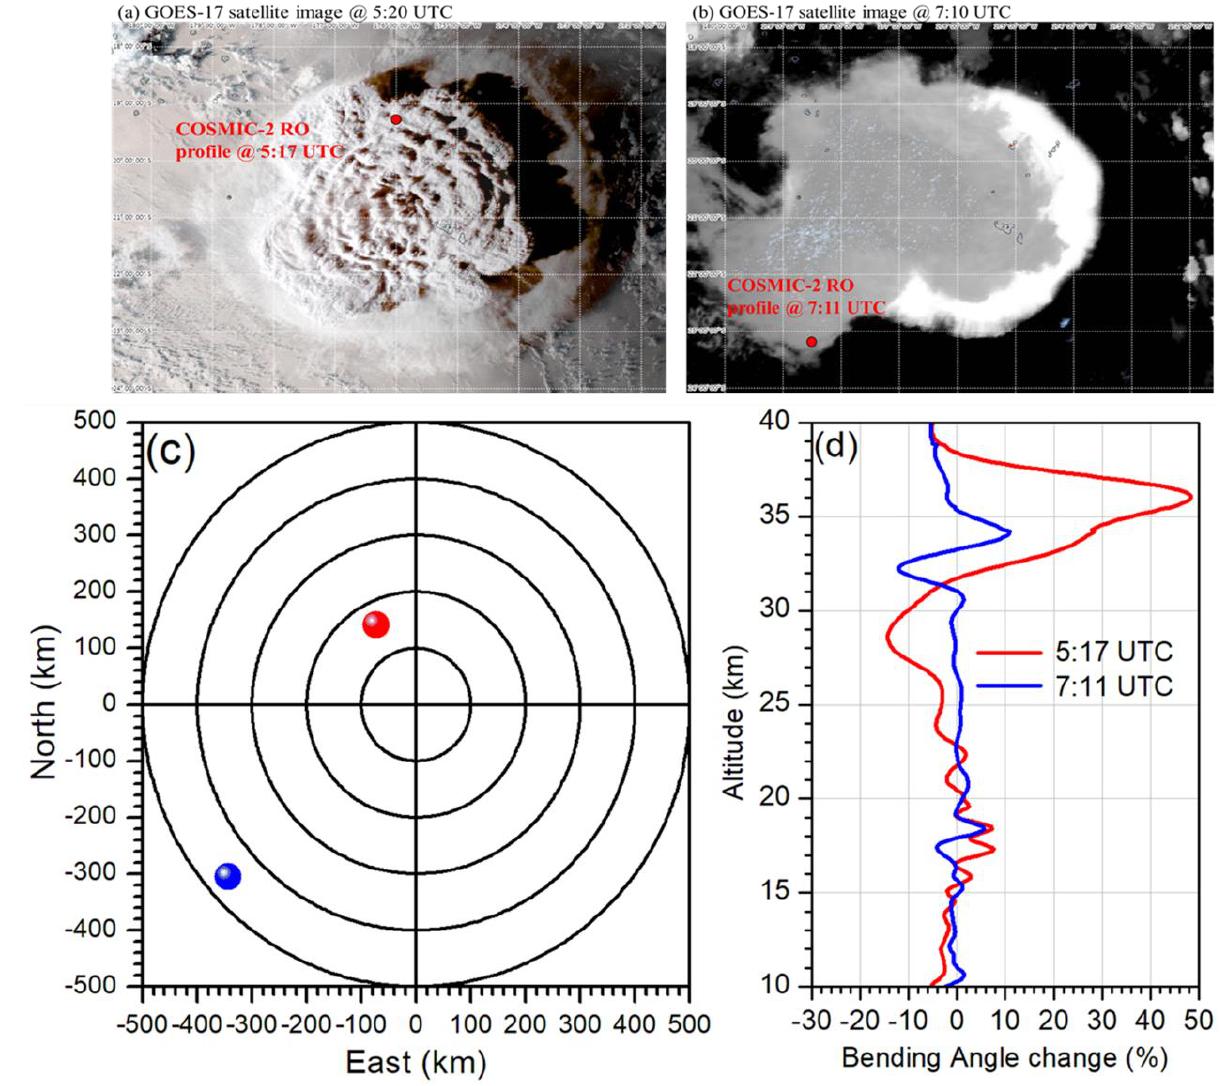
Figure 2. Top panel shows ( a ) GOES – 17 Geo Color, multispectral blended infrared image, observed at 5:20 UTC, and ( b ) at 7:10 UTC on 15 January 2022. The red-colored (blue) dot represents the available COSMIC – 2 RO profile at 5:17 (7:11) UTC. ( c ) The location of the aforementioned RO profile concerning Tonga volcano center. The bottom panel shows perturbations of ( d ) the bending angle for the aforementioned RO profile concerning the reference profile (mean of 7 – 13 January 2022).